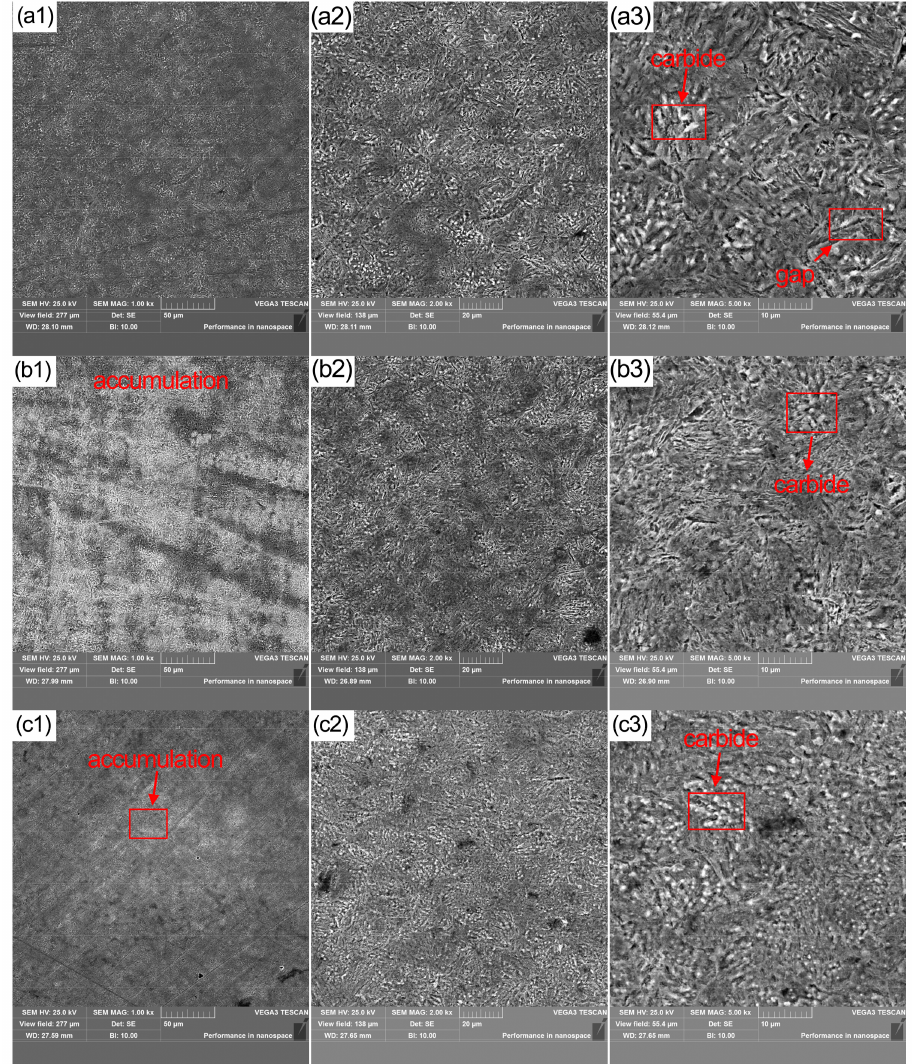
Figure 3. Microstructure of 42MrCo samples after different cryogenic temperature (SEM, magnifica- tion ( a1 , b1 , c1 ) 1000 × , ( a2 , b2 , c2 ) 2000 × , ( a3 , b3 , c3 ) 5000 × ), ( a ) − 120 ◦ C, ( b ) − 160 ◦ C, ( c ) − 190 ◦